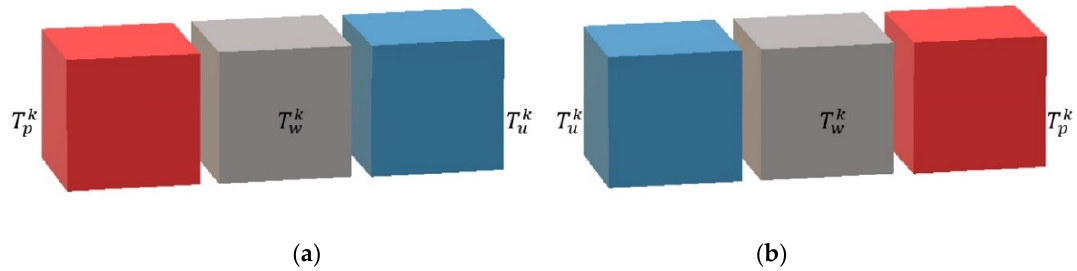
Figure 7. ( a ) Representation of a cell k of plate wall with process plate in the left and utility plate in the right; ( b ) Representation of a cell k of plate wall with process plate in the right and utility plate in the left.